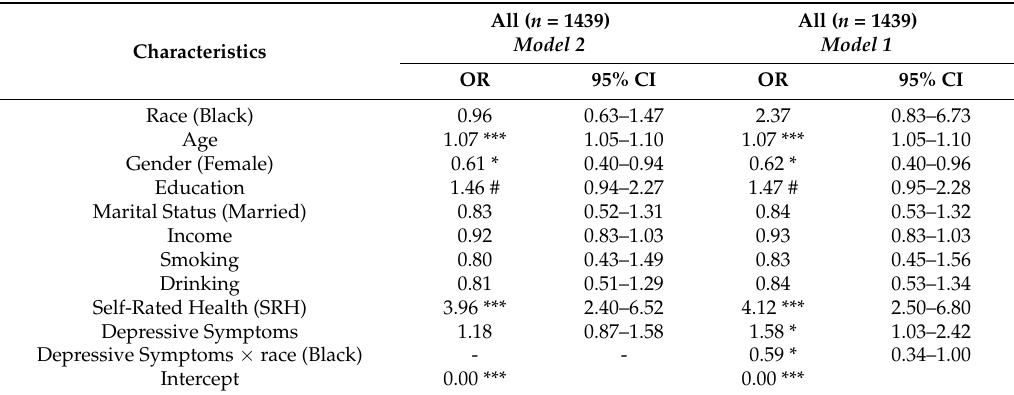
Table 2. Association between baseline depressive symptoms (2001) and all-cause mortality (2001–2004) using logistic regression in the pooled sample ( n =